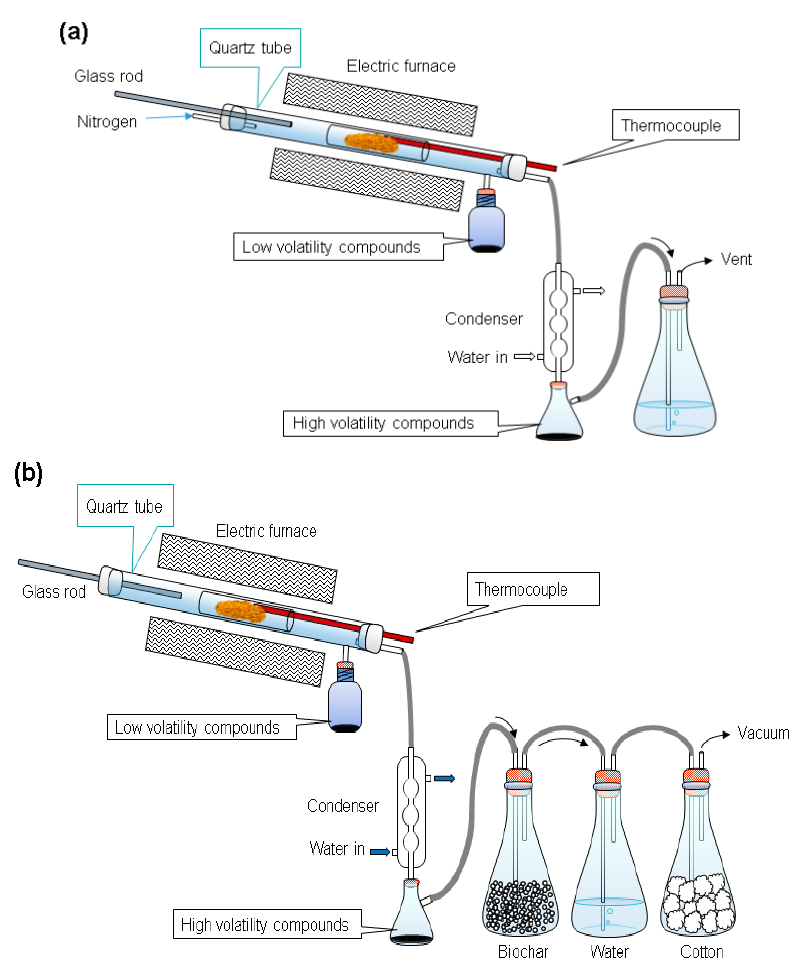
Figure 1. The experimental setups for the ( a ) nitrogen and the ( b ) vacuum systems.